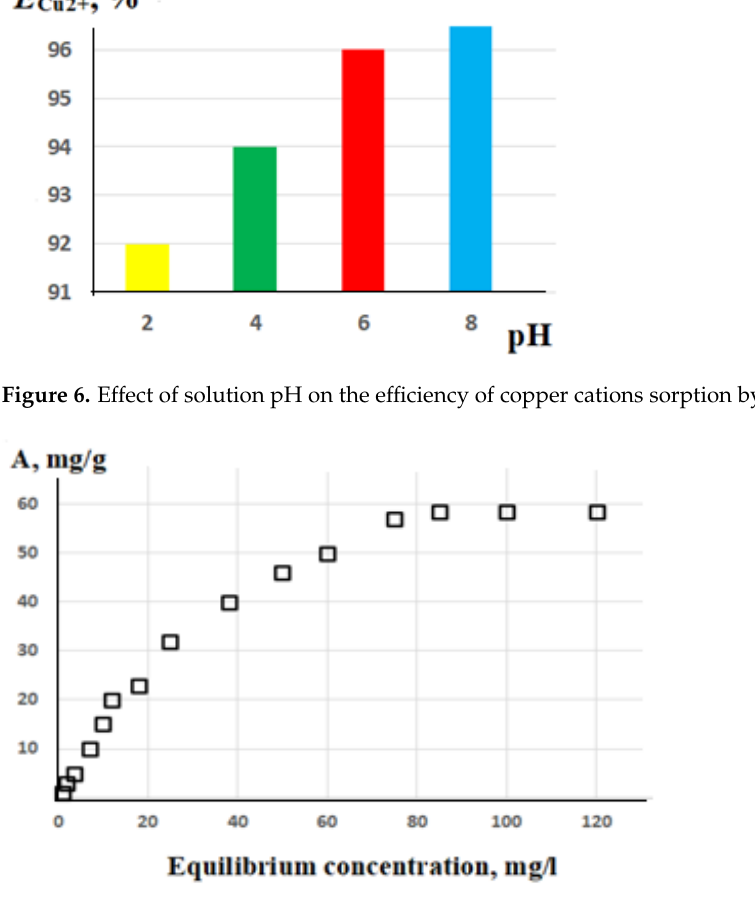
Figure 7. Isotherm of copper cation sorption by GO-Ch composite (sample No. 4).